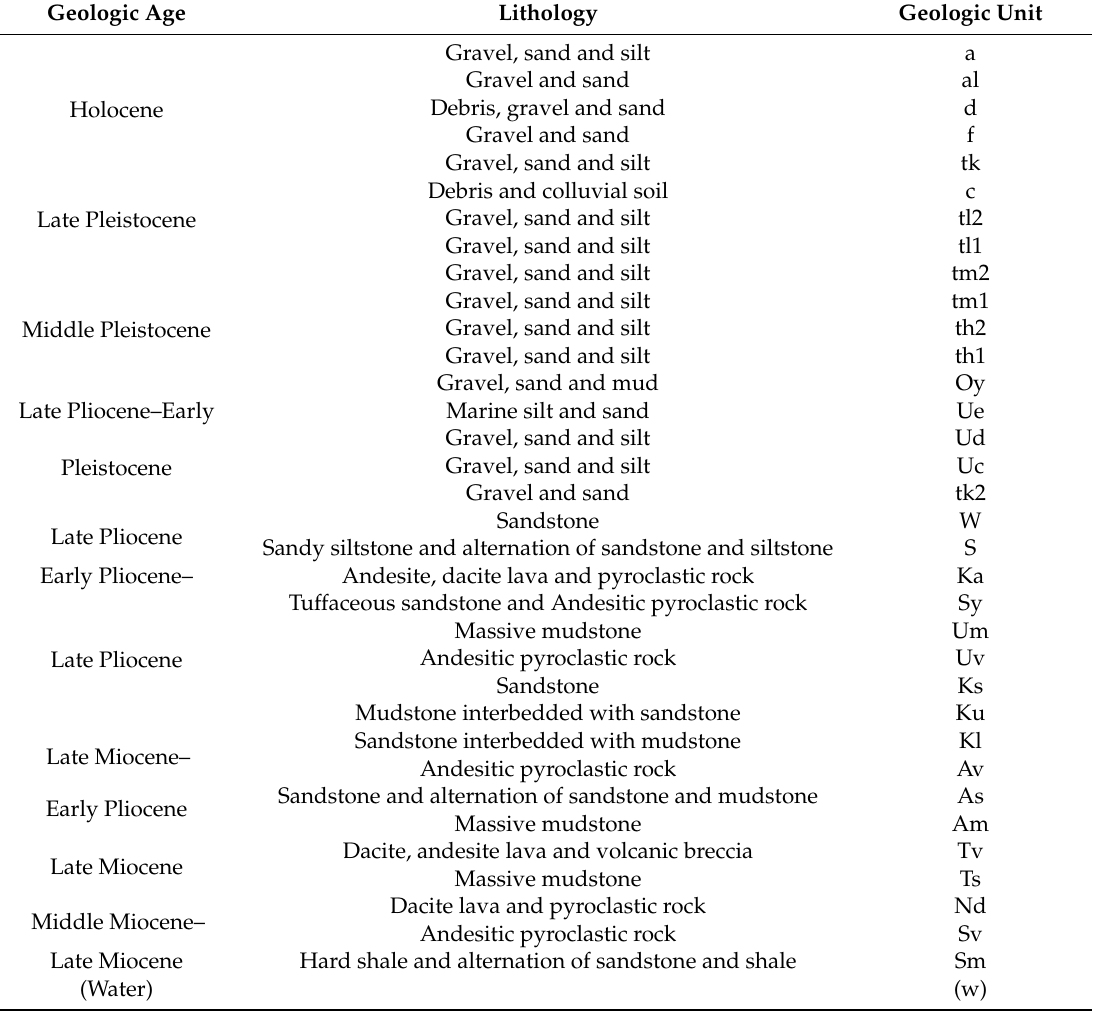
Table 2. Classification of geologic substrata in the study area (revised from Takeuchi and Yanagisawa,